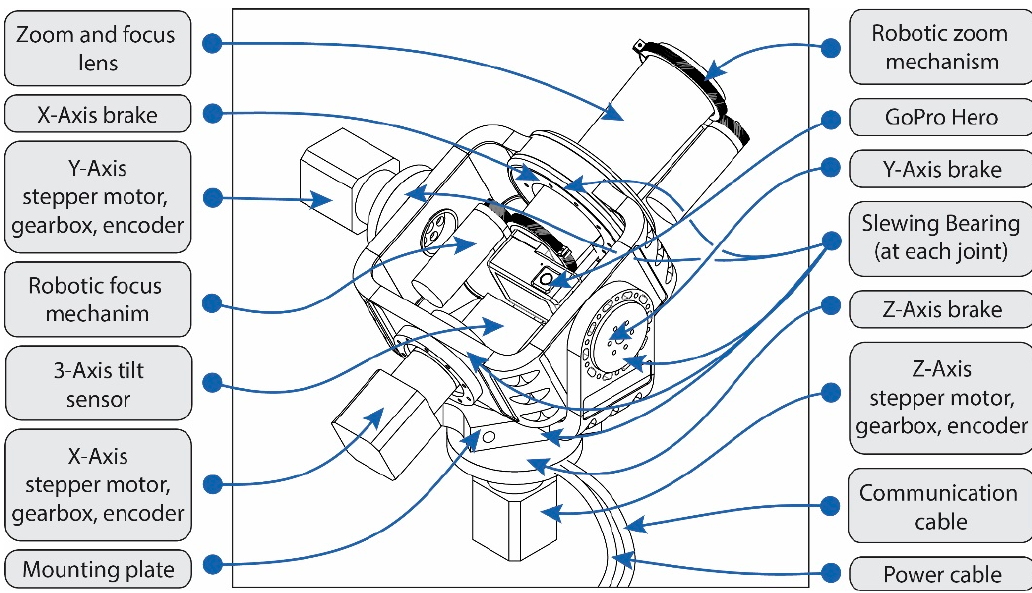
Figure 11. A vision of three-axis robotic gimbal.